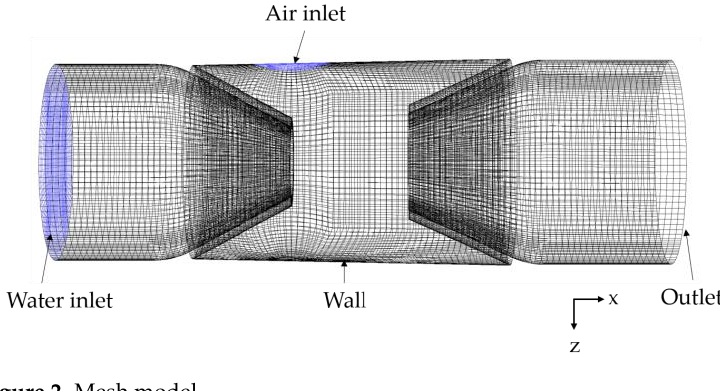
Figure 2. Mesh model.